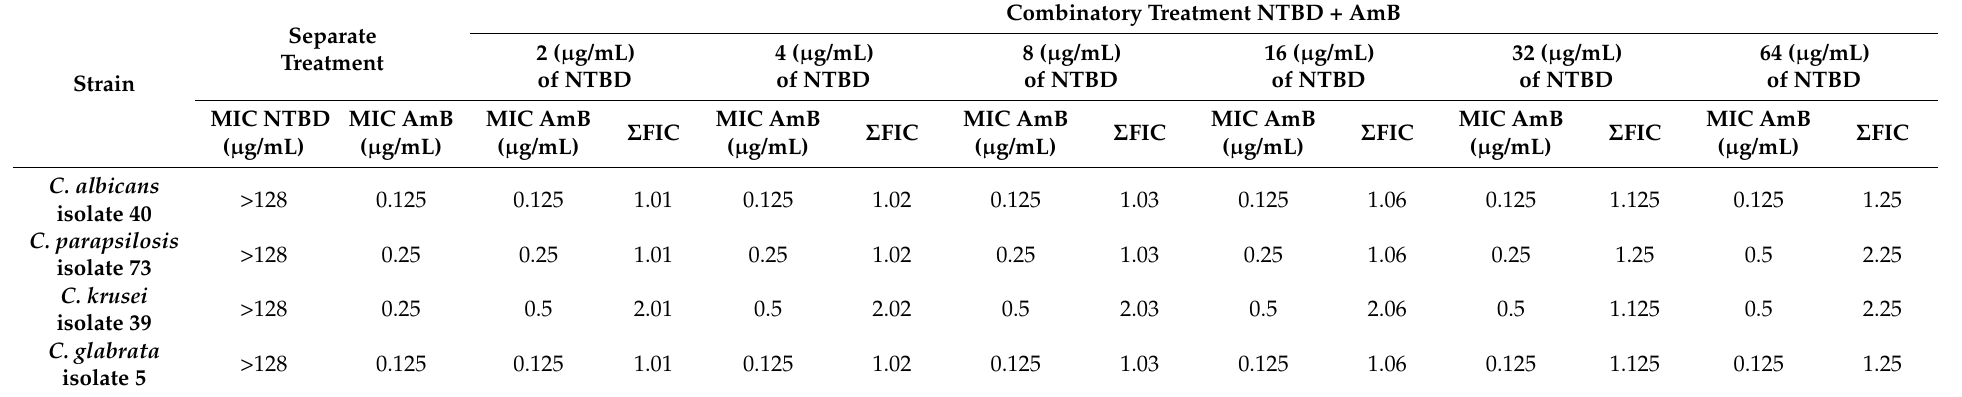
Table 3. Interactions of NTBD with AmB against clinical strains in vitro after 48-h incubation. MIC—minimal inhibiting concentration of the compound, ∑ FIC—coefficient, which is the sum of partial concentrations inhibiting the growth of the pathogens. The interactions were determined based on the